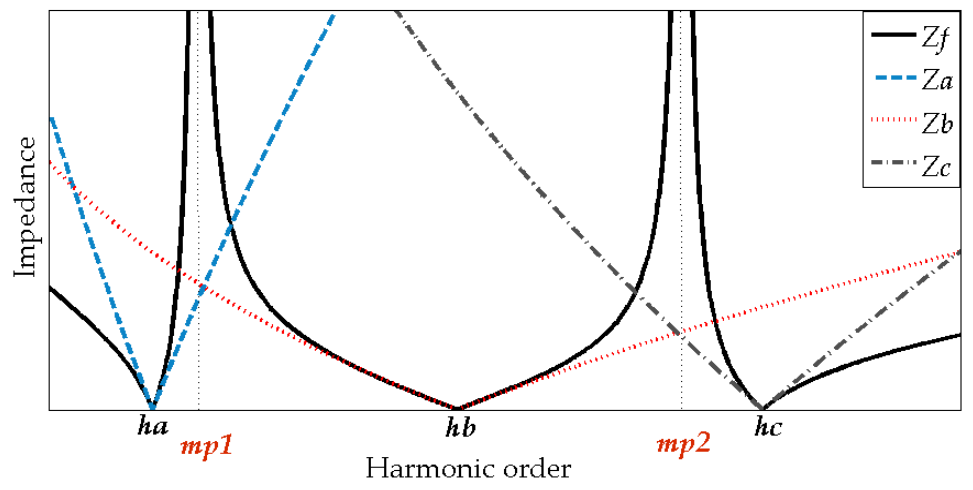
Figure 2. Impedance characteristic of the TASTF.